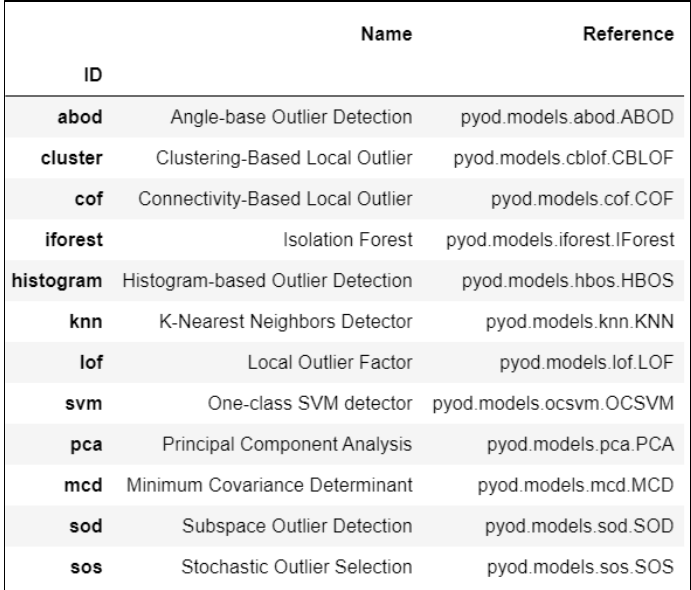
Figure 2. Output of models() function.